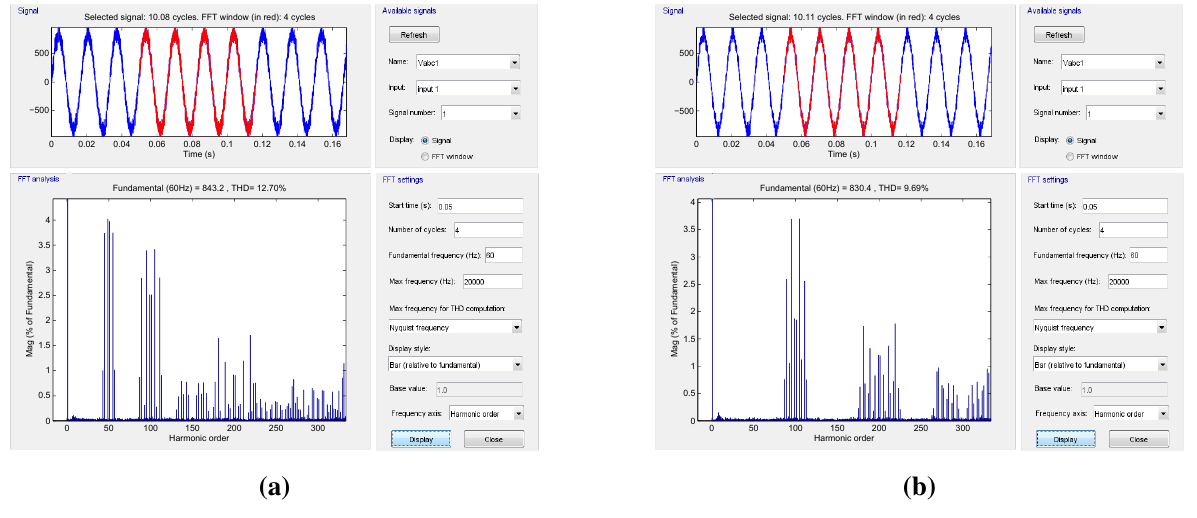
Figure 6. Voltage (referring to the ground) FFT measured before the filtering impedance. The fundamental frequency is not fully visualized in order to clearly see the higher harmonics. ( a ) FFT of phase to ground voltage: interleaving applied, P m = 0 . 8 MW, P t = 1 MW. The power ratio does not achieve the optimal condition; ( b ) FFT of phase to ground voltage with the optimal power condition: interleaving applied, P m = 0 . 33 MW, P t = 1 MW.